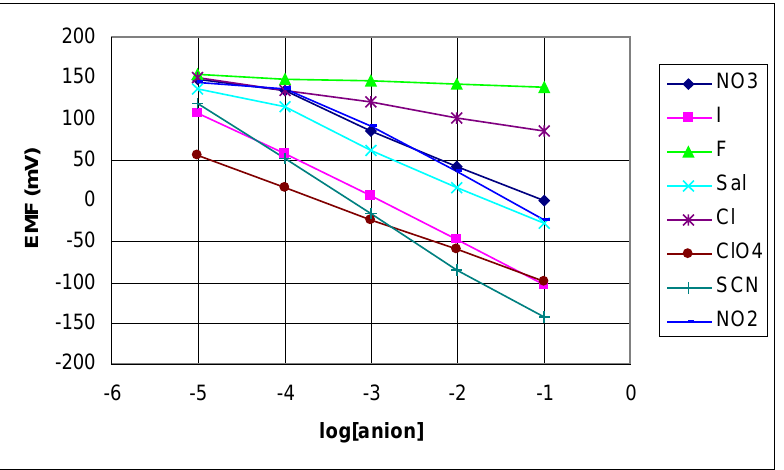
Figure 5. Potentiometric anion responses of the electrodes prepared with a membrane having the optimal